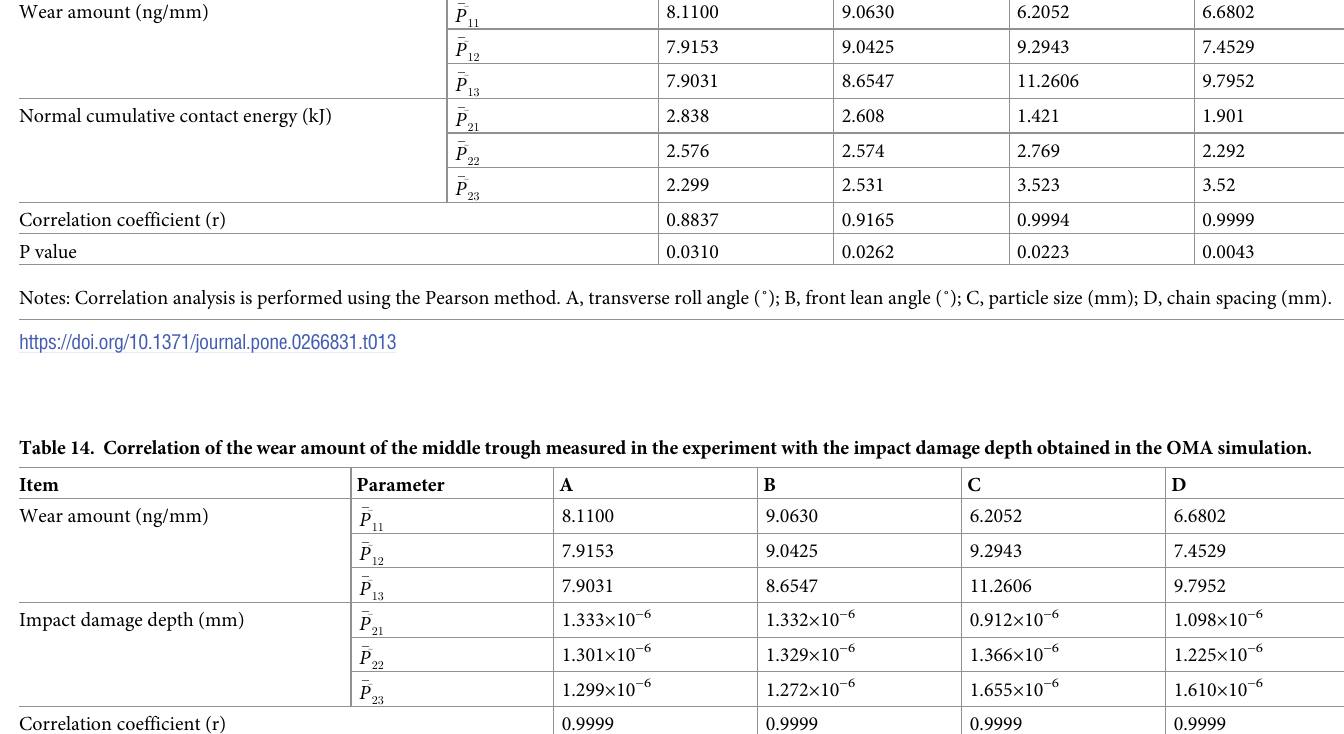
Table 13. Correlation of the wear amount of the middle trough measured in the experiment with the normal cumulative contact energy obtained in the OMA simulation. Item